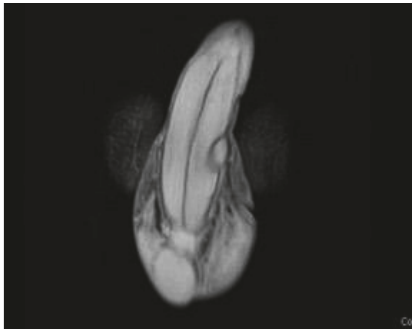
Figure 2: MRI of the penis T2 sagittal, demonstrating a distinct nodule on the dorsal aspect of the penis.